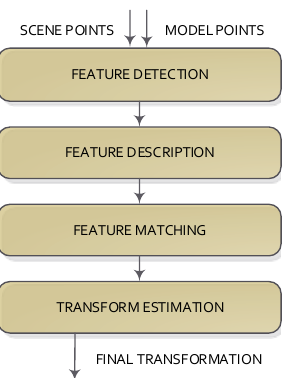
Figure 3. Basic scheme of the feature registration